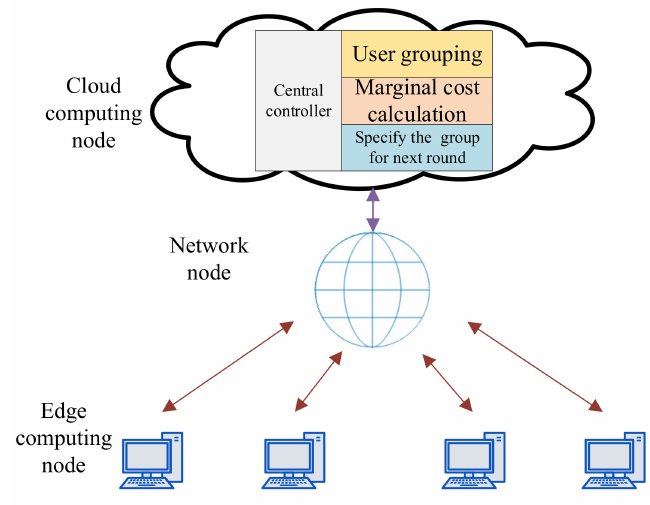
Figure 6. Edge computing architecture for coordinated